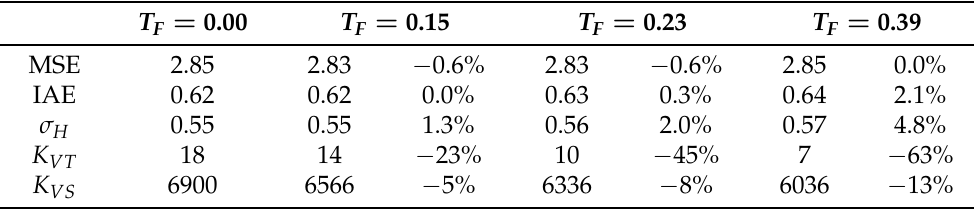
Table 5. Filtering impact on G 2 ( s ) loop.